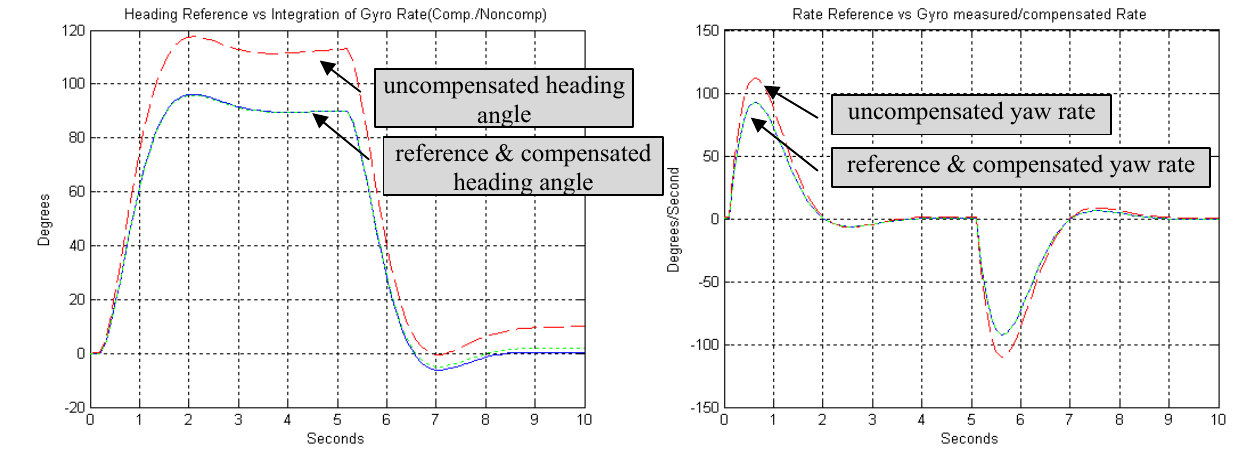
Figure 6. LS algorithm with heading reference. Figure 7. LS algorithm with rate